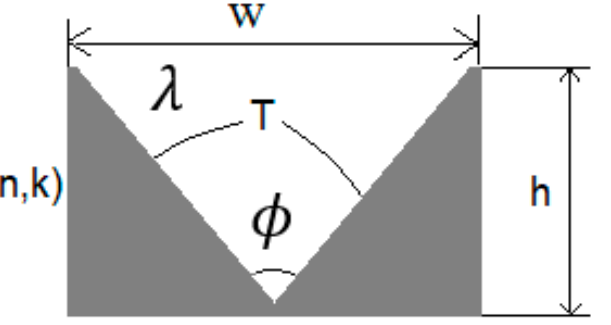
Figure 2. V groove parameters.